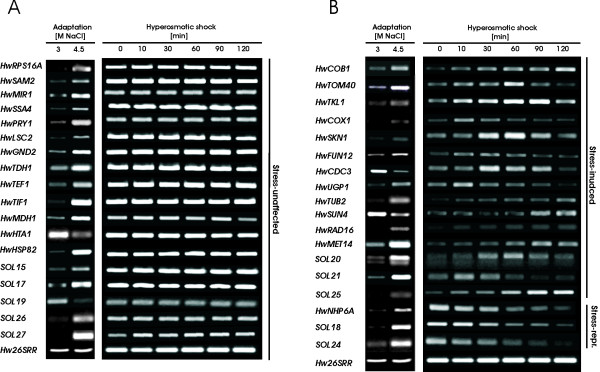
Expression profiles of HwHog-ChIP negative genes in adapted and stressed H. werneckii cells. RT-PCR was performed with RNA isolated from cells adapted to 3 M and 4.5 M NaCl (Adaptation) or cells exposed to hypersaline stress at indicated time points (Hyperosmotic stress). 26S rRNA (Hw26SRR) was used as an internal control for template normalization. Genes whose expression was not affected by salt-stress are presented in (A) and those that responded to salt stress are presented in (B).